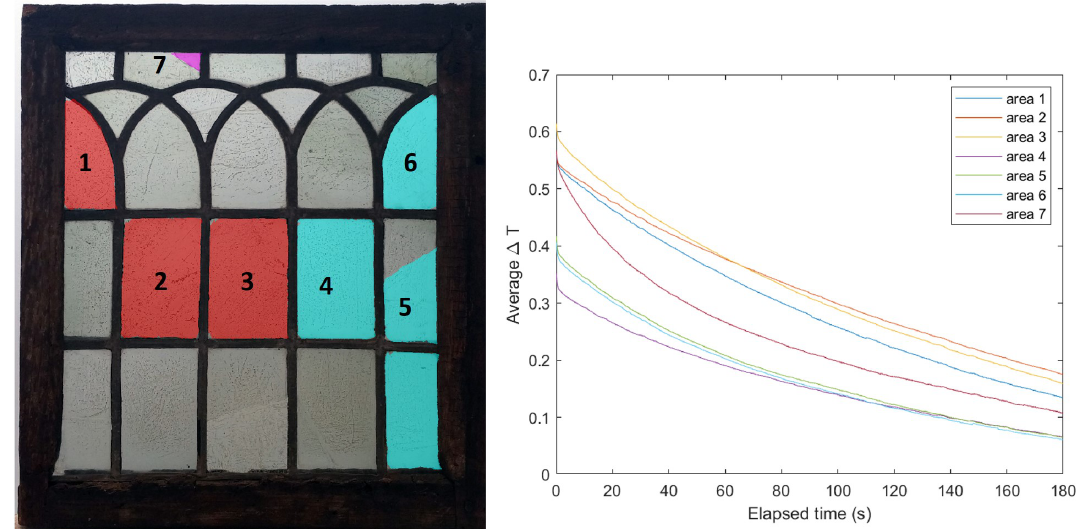
Figure 8. Left: Image of the leaded-glass window where the glass pieces are color-coded according to the group they belong to, based on our interpretation of the results. Right : Average temperature difference plots over time for the numbered glass pieces. The temperature differences are normalized over the entire data cube. The temperature data originates from the upper area measurement in reflection